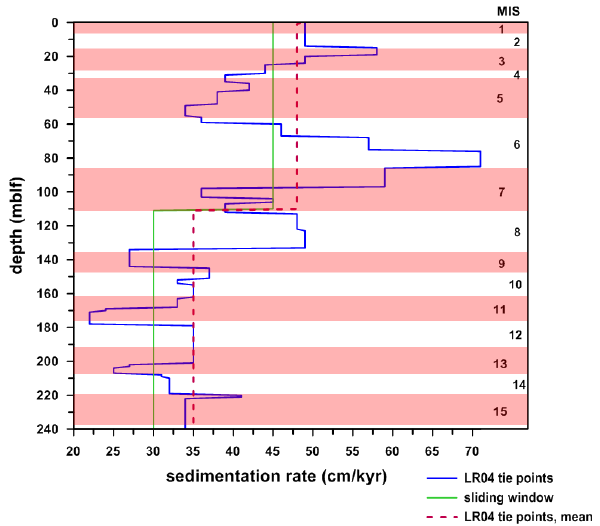
Figure 4. Estimates of sedimentation rates from 0 to 240mb.l.f. based on visual correlation and tying to the timescale of LR04 (blue; Lisiecki and Raymo, 2005) and sliding window analysis with link- ing of high amplitudes to the 100kyr cycle (green). The sedimenta- tion rates from sliding window analysis show an increase from 30 to 45cmkyr − 1 at about 110mb.l.f., whereas results from tie points are more variable and range from 22 to 71cmkyr − 1 . The dashed red line indicates the mean values of the sedimentation rates from LR04 tie points for interval I and II. Marine isotope stages (MIS) from 1 to 15 are labelled.